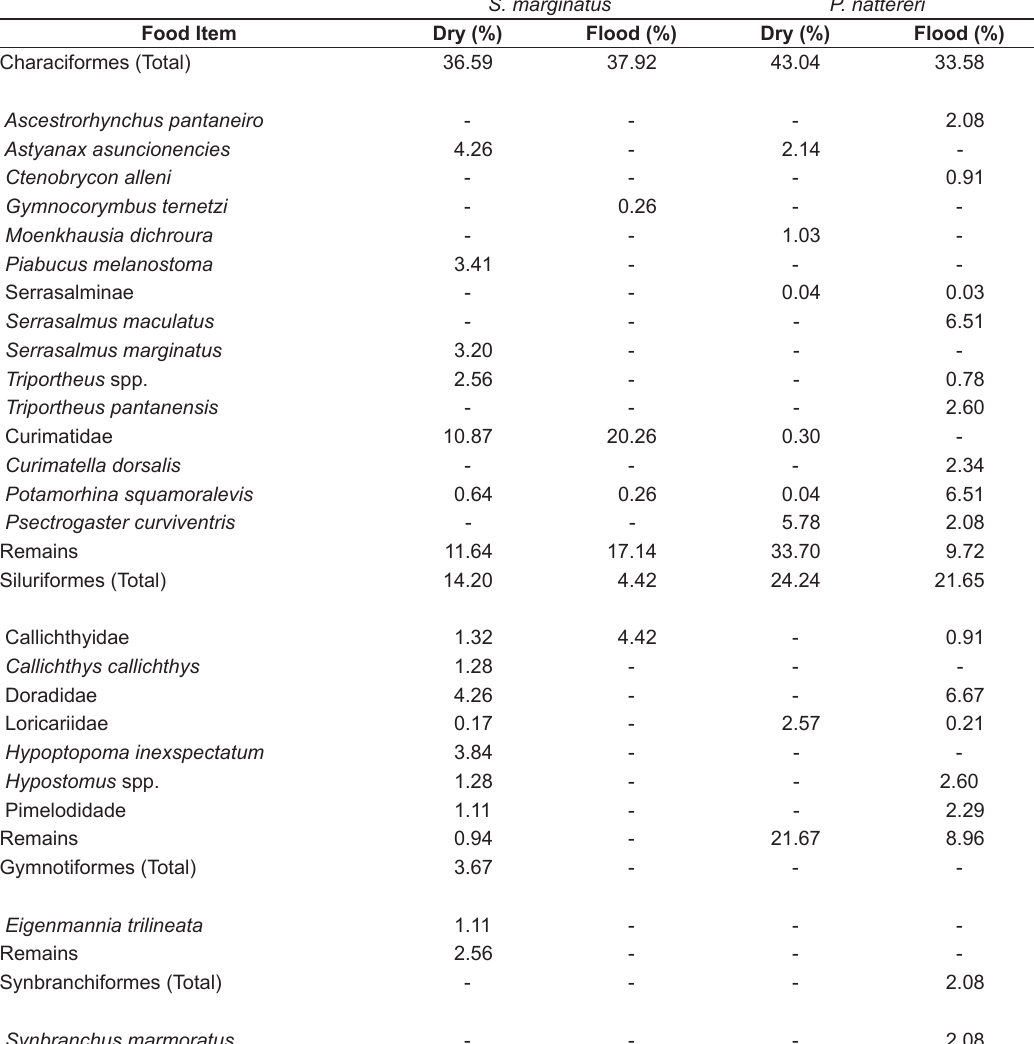
Table 2. Details of the main fish orders identified to species level, according to the volumetric frequency of food items in Serrasalmus marginatus and Pygocentrus nattereri in the dry and flood seasons, caught in the Negro River, Nhecolândia region, Pantanal, from October 2005 through August